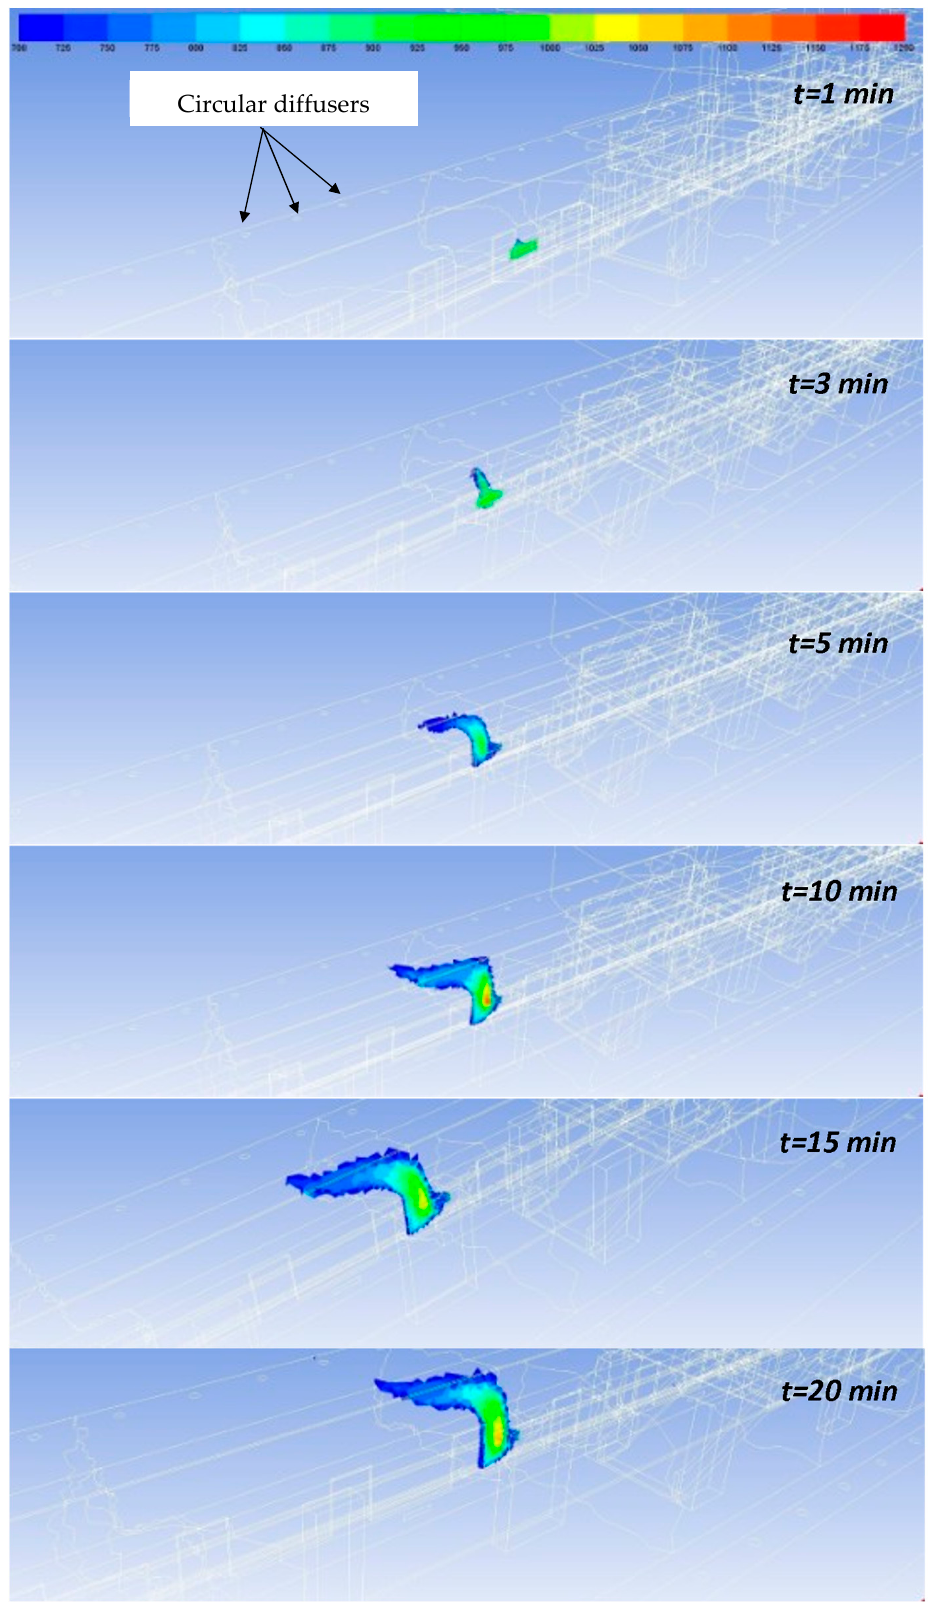
Figure 28. CO 2 distribution (ppm)—area above the fire outbreak.